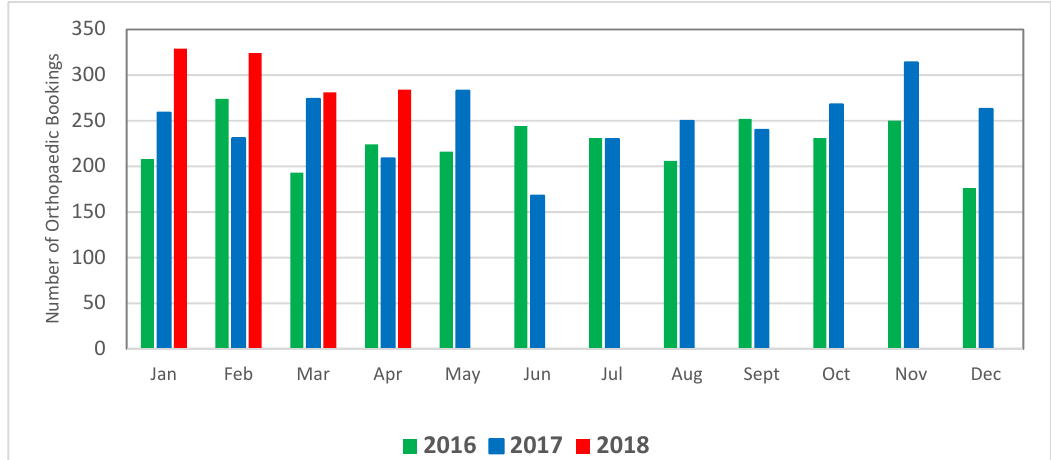
Figure 1. Number of orthopaedic surgeries scheduled for 2016, 2017, and 2018.